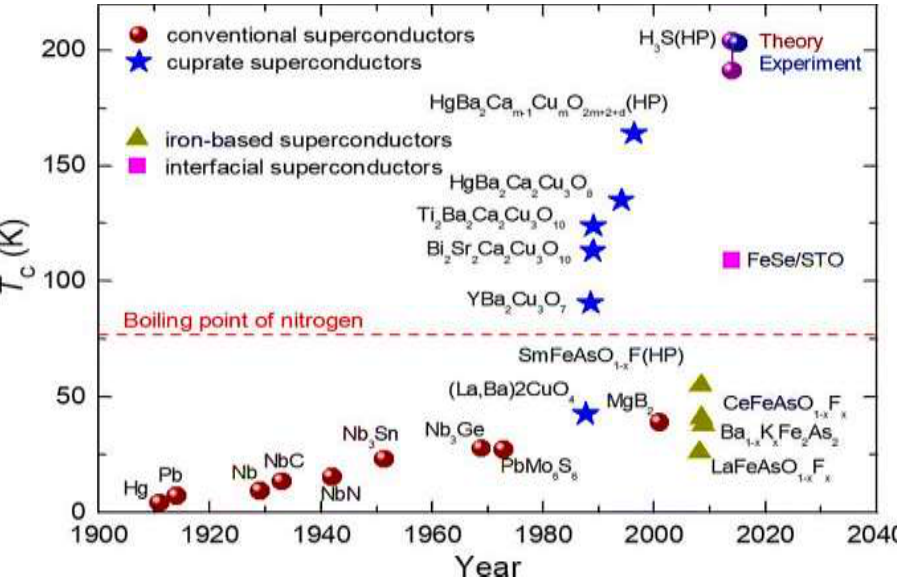
Figure 5: Discovery Time of Superconductors and Critical